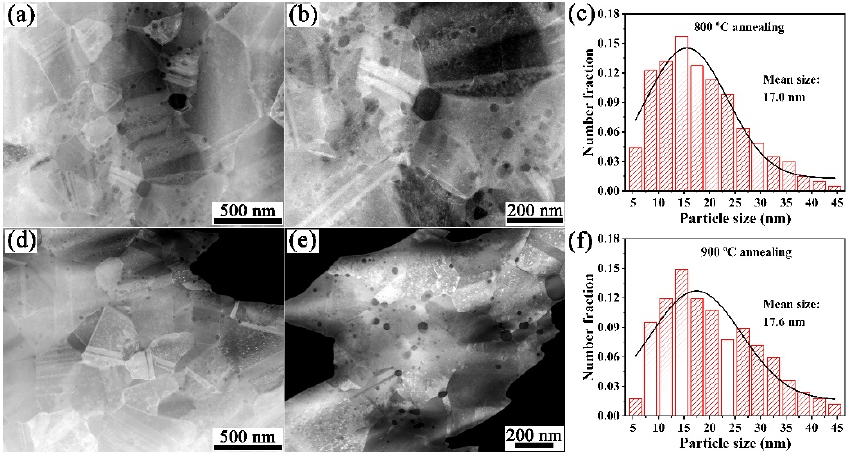
Figure 6. HAADF-STEM images and Y 2 O 3 particles size distribution after annealing at different tem- peratures: ( a – c ) 800 °C annealing; ( d – f ) 900 °C annealing. temperatures: ( a – c ) 800 ◦ C annealing; ( d – f ) 900 ◦ C